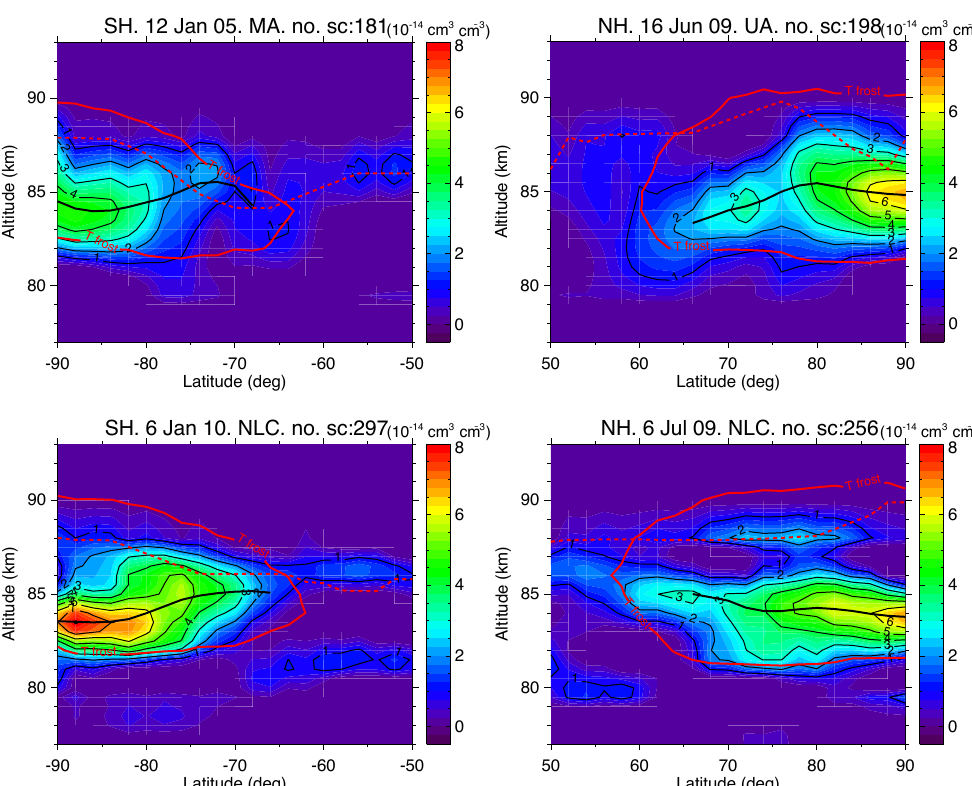
Figure 1. Zonal mean ice volume density during four days, two in the SH and two in the NH, as measured by MIPAS in different observation modes (MA, UA, and NLC, see labels). The solid red lines indicate the frost-point temperature. The red dashed line is the mesopause as derived from MIPAS. The black solid line is an estimated mean altitude (weighted with the ice density to power of 4) of the PMC layer. The number of measured profiles, “#sc”, is also shown. The noise error of the mean volume density plotted here, estimated by the standard error of the mean, is about 0.3 × 10 − 14 cm 3 cm − 3